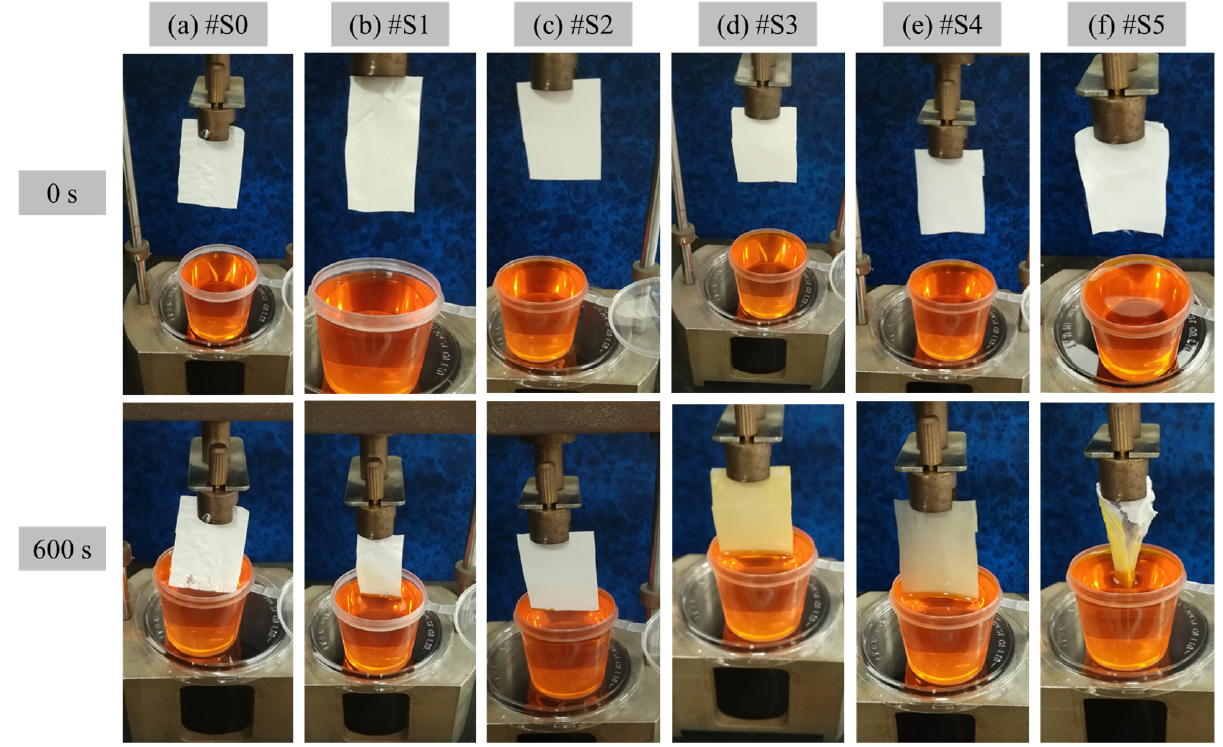
Figure 8. WTR of the electrospun ( a ) PLA (#S0) and ( b – f ) PLA/PEG-PPG-PEG-blended (#S1–#S5) nanofibers at 0 and 600 s.